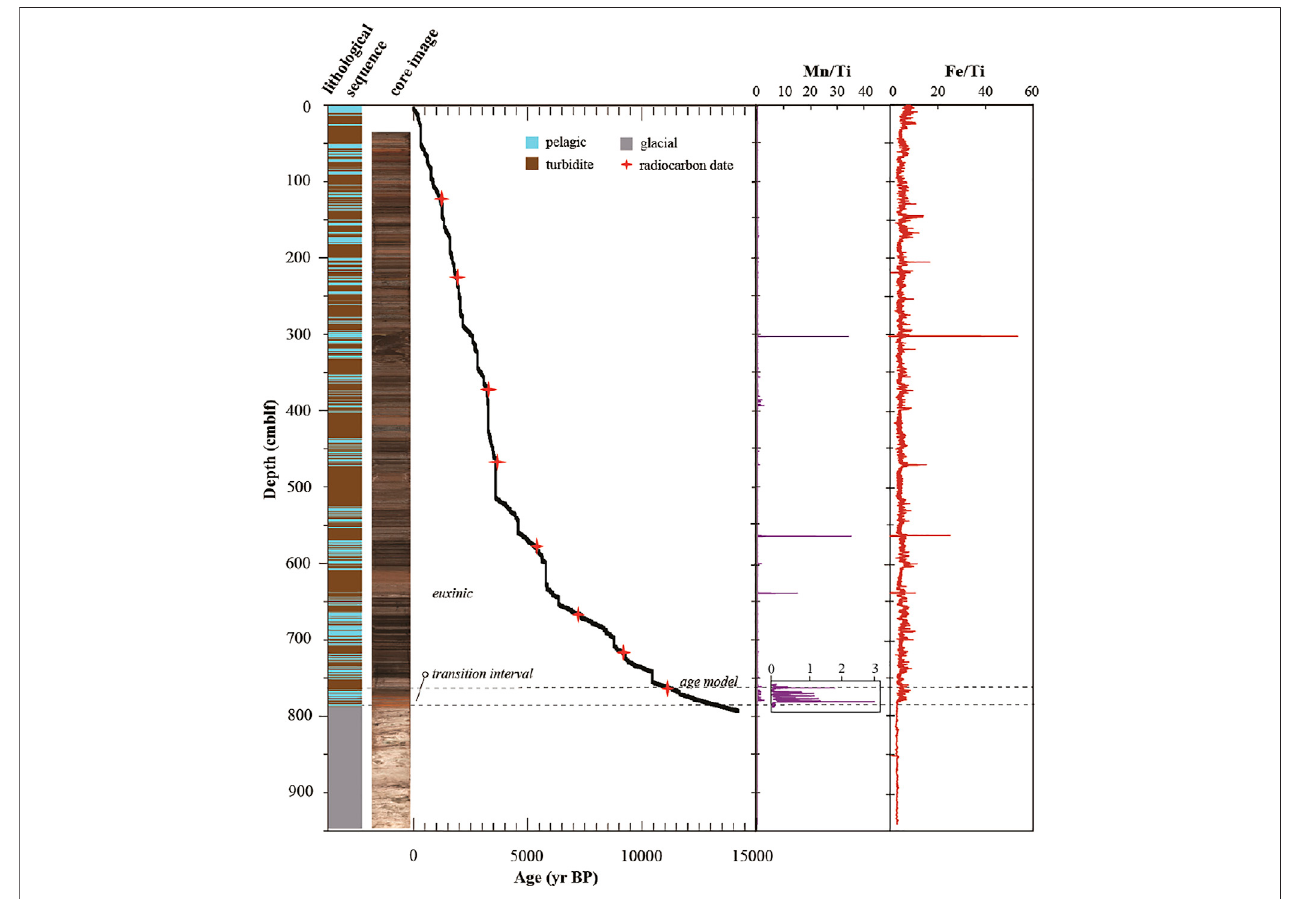
FIGURE 1 | (Left) Lithological pro fi le determined from a composite core image of the sedimentary sequence retrieved from Lake Cadagno. The age model was calibratedwithpreviouslyobtainedradiocarbondatesfromcorrespondingsedimentarylayers(Wirthetal.,2013).(Right)XRFpro fi lesofFe/TiandMn/Ti.Insetshowsthe Mn enrichment in the redox transition